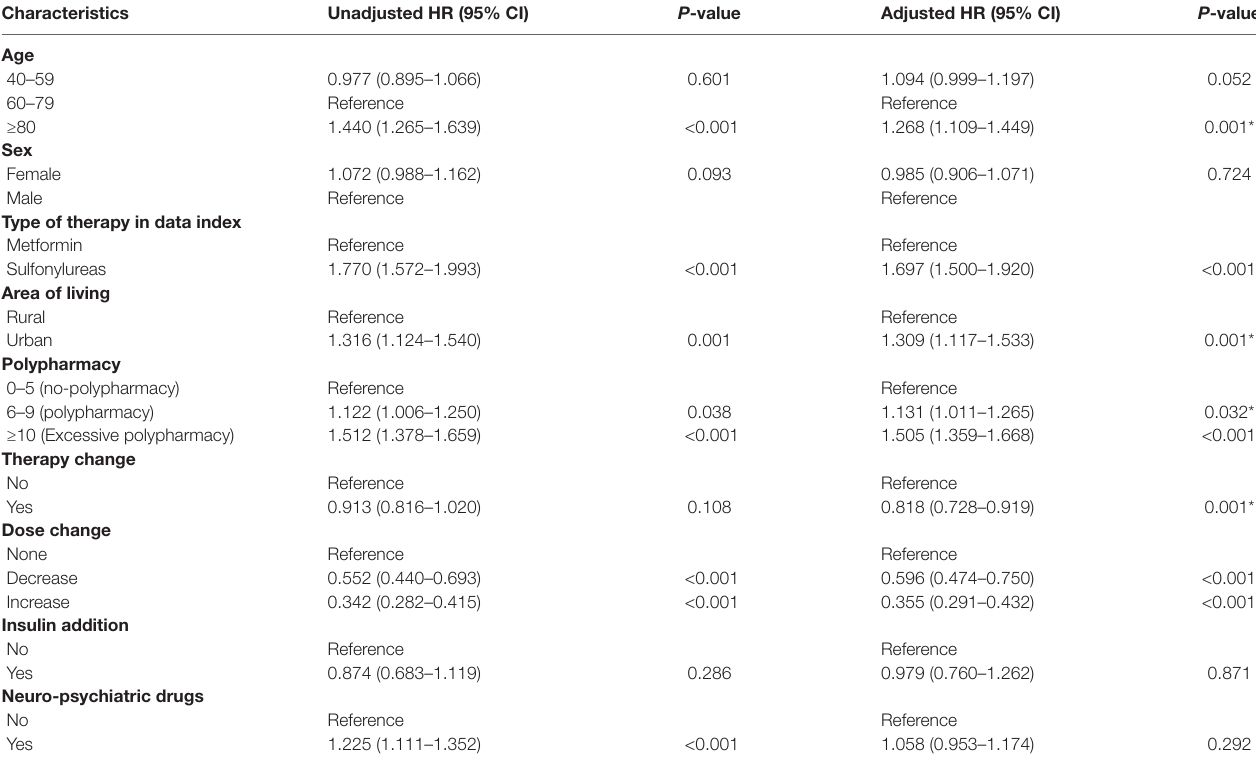
TABLE 4 | Predictors of non-persistence to antidiabetic therapy at 1-year